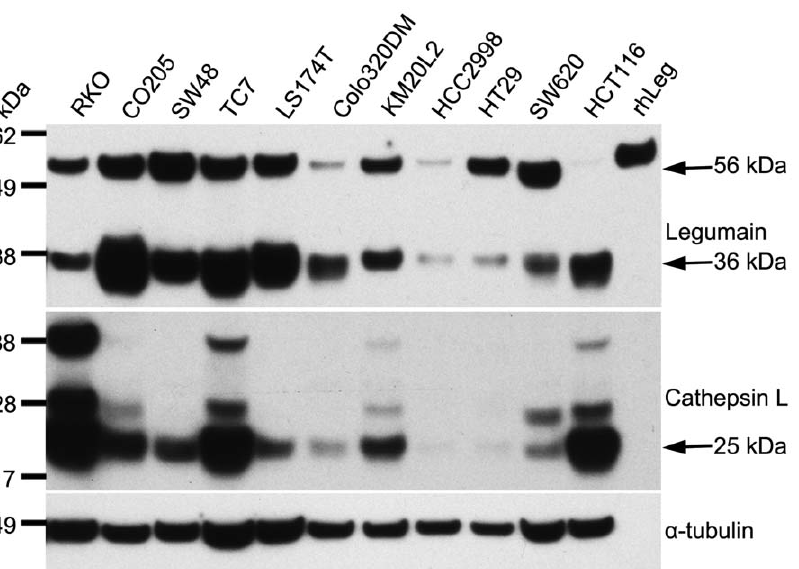
Figure 1. Expression of legumain and cathepsin L in CRC cell lines. Immunoblots of cell lysates from a panel of CRC cell lines demonstrated high variability in the total amount of legumain and cathepsin L, and also in the presence of the different mature forms. HCT116 and SW620 cells were particularly interesting as they show mutually exclusive high amount of the active (36 kDa) and inactive pro-form (56 kDa) of legumain, respectively. Uncut immunoblots (Fig. S2A).